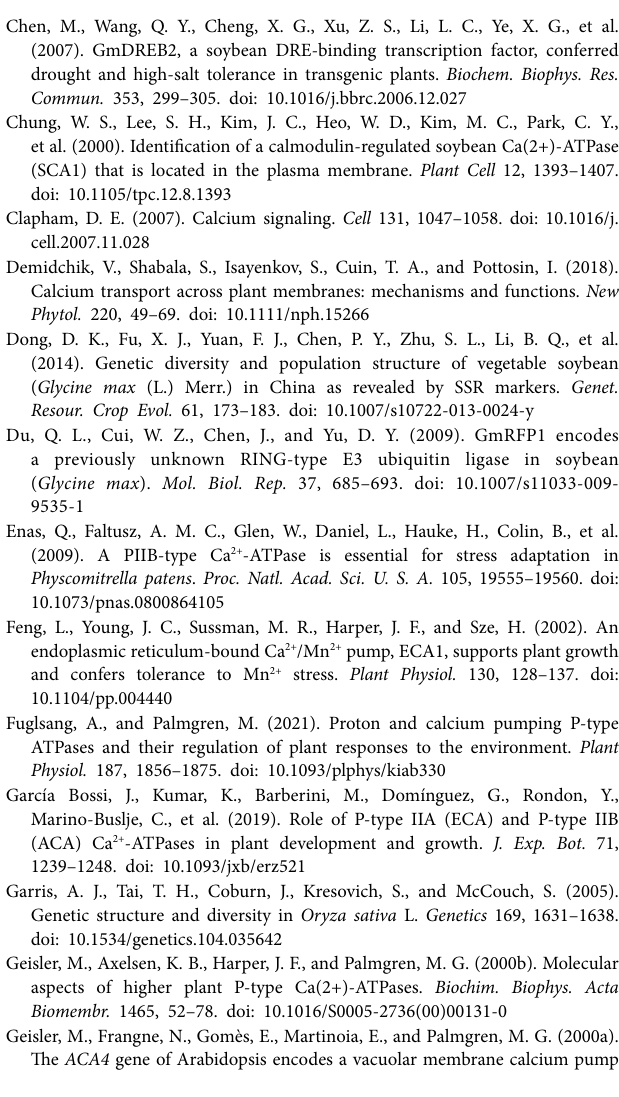
Supplementary Figure S2 | Functional domains analysis of P2-type ATPases proteins in Arabidopsis and Glycine max from an evolutionary level. The differently colored boxes represent different conserved domains and their positions in each P2-type ATPases protein sequence. Supplementary Figure S3 | Alignment of multiple soybean P2-type ATPases proteins and conserved domains amino acid sequences. Supplementary Figure S4 | Gene structures composition of the P2-type ATPases genes from Arabidopsis and Glycine max . Exon-intron structures of P2-type ATPases genes. Solid green boxes indicate untranslated 5 ′ - and 3 ′ -regions; solid yellow boxes indicate exons; and black lines indicate introns. The number indicates the phases of the corresponding introns. The protein length can be estimated using the different scales at the bottom. Supplementary Figure S5 | Schematic representations of the chromosomal distribution of the soybean P2-type ATPases genes. The chromosome number is indicated to the left of each chromosome. Supplementary Figure S6 | Correlation analysis of expression levels and the stomatal aperture of P2-type ATPases genes under four abiotic